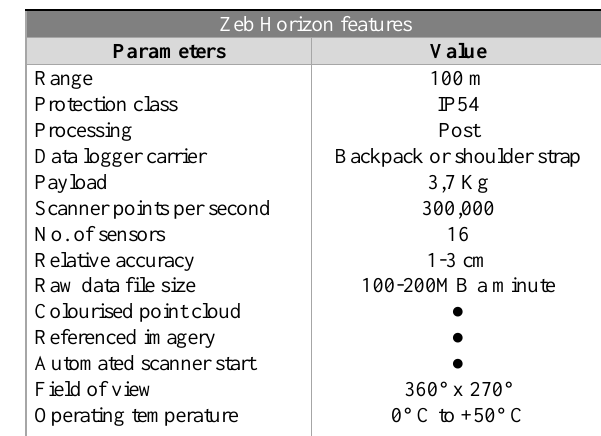
Figure 3. Methodological phases of the procedural pipeline.